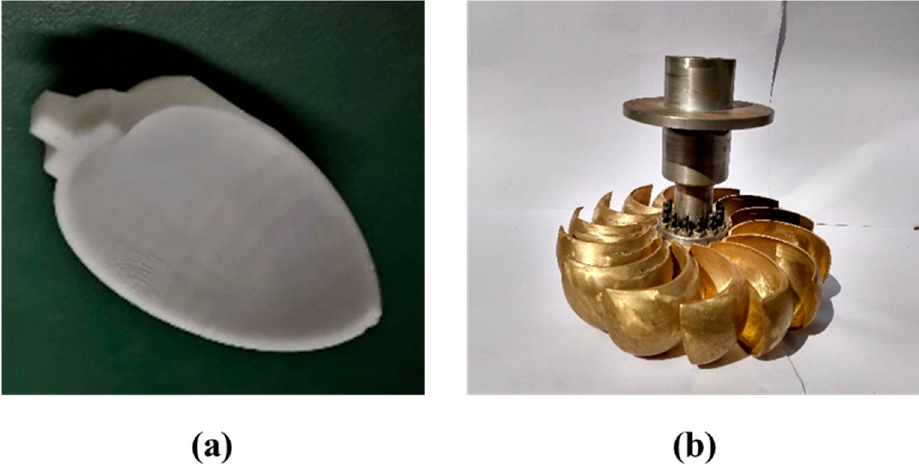
Figure 21. ( a ) The 3D-printed pattern and ( b ) assembled bolted runner with cast brass blades.